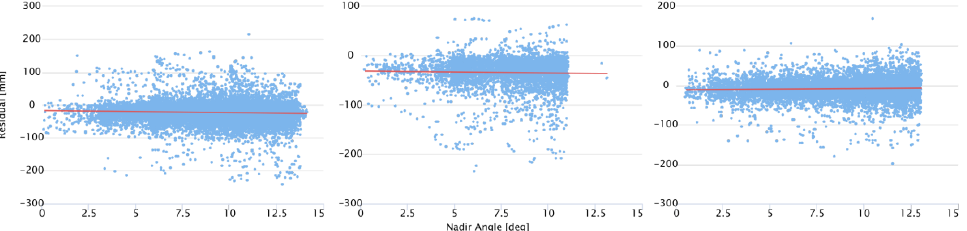
Figure 5. SLR residuals to GLONASS-M satellites as a function of the nadir angle for selected SLR stations. Description of a title: place, detector type, regression slope of SLR residuals as a function of nadir angle, bias in nadir